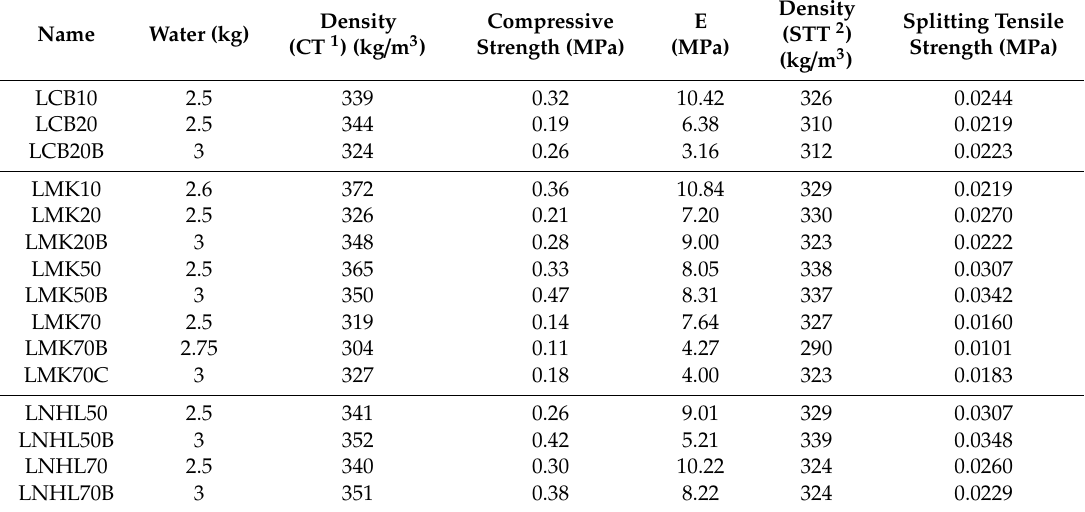
Table 3. Average compression strength, tensile strength, Young’s modulus, density, and water